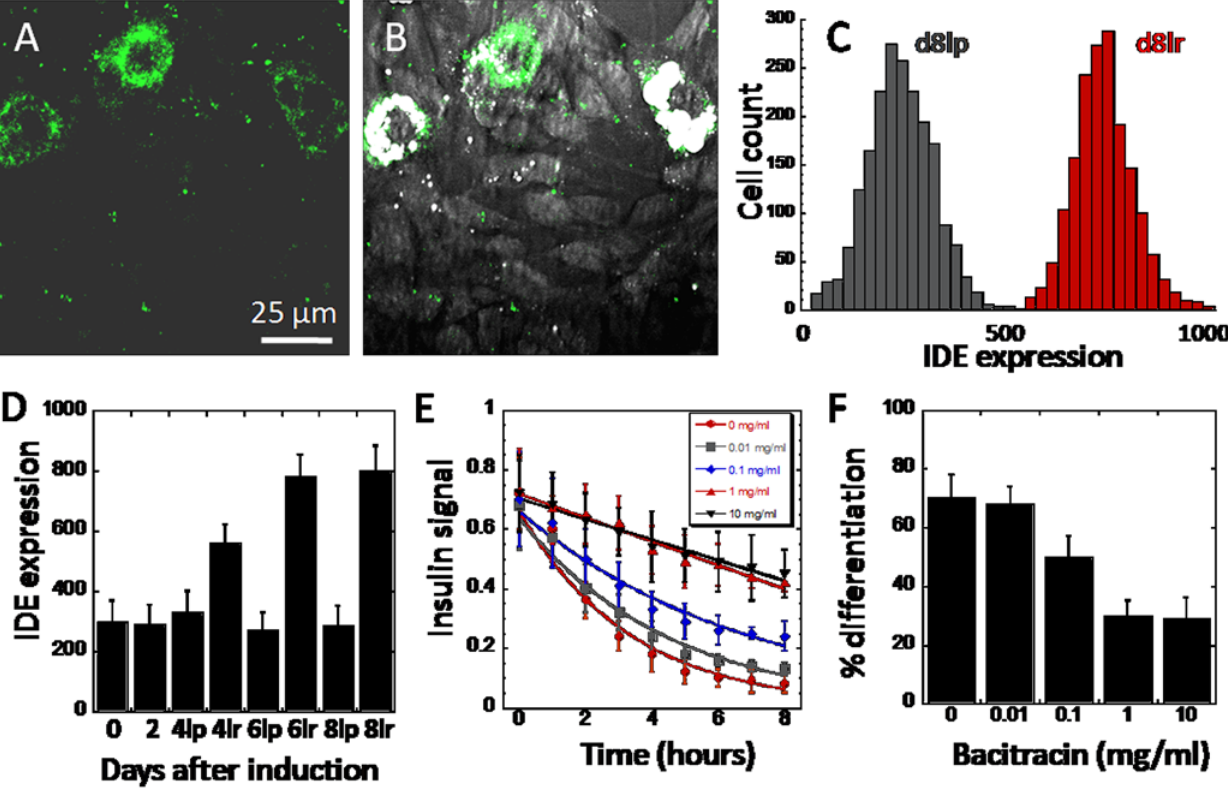
Figure 7. Increased expression of insulin degradation enzyme in lipid-rich cells. ( A ) TPEF imaging of fluorescent immuno-labeled insulin degradation enzyme in cells at day 8. ( B ) Overlay of TPEF imaging of IDE and CARS imaging of lipids. ( C ) Flow cytometry analysis of IDE expression level of lipid-rich cells (red) and lipid-poor cells (grey) at day 8. ( D ) Quantitative flow cytometry analysis of IDE expression level as a function of days after induction. lr and lp represent lipid-rich and lipid-poor cells at given days after induction. Error bars represent distribution across 4 repeated experiments. ( E ) Insulin signal decay as a function of bacitracin concentration. Undifferentiated cells at day 0 are used. ( F ) Percentage of cell differentiation as a function of bacitracin concentration. Error bars represent distribution across 4 repeated